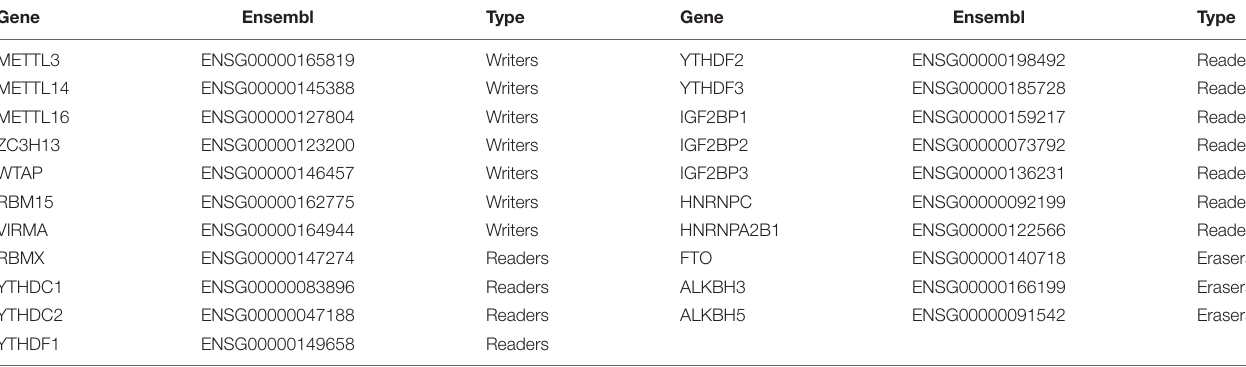
TABLE 2 | The description of 21 m6A RNA methylation regulators from publications.